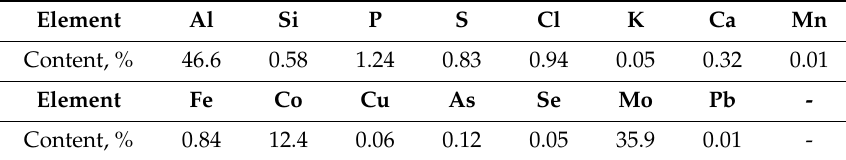
Table 7. Percentage content of elements in spent industrial CoMo catalyst. Element Al Si